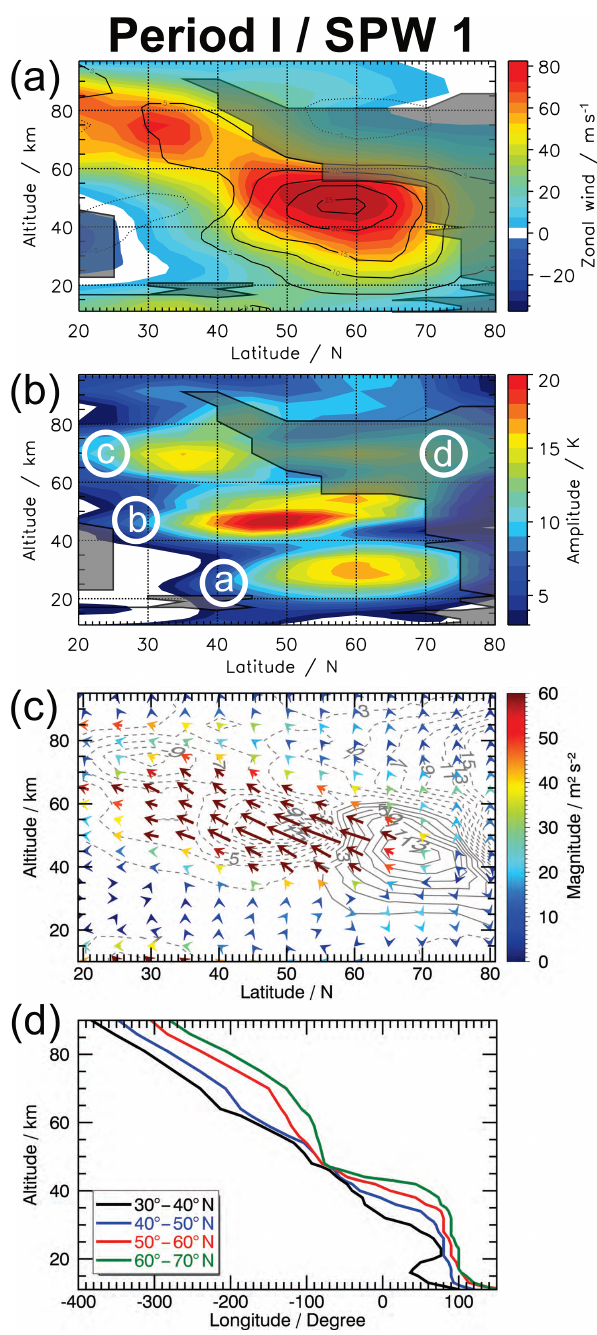
Figure 2. Latitude–altitude cross sections of (a) the zonal mean zonal wind in colored contours, the deviation of each time period from its 12-year mean in black contour lines with steps of 5ms − 1 and the areas where the refractive index squared n 2 is negative are shaded grey; (b) the amplitude of the SPW 1, areas where the refrac- tive index squared n 2 is negative are shaded grey; (c) Eliassen–Palm flux vectors of the SPW 1 with the magnitude of the flux is given by the length of the vector as well as by their color, contour lines present the EP-flux divergence in ms − 1 per day; and (d) phase in- formation of each SPW depending on the altitude and for different latitude bands. All data presented here are derived from MLS